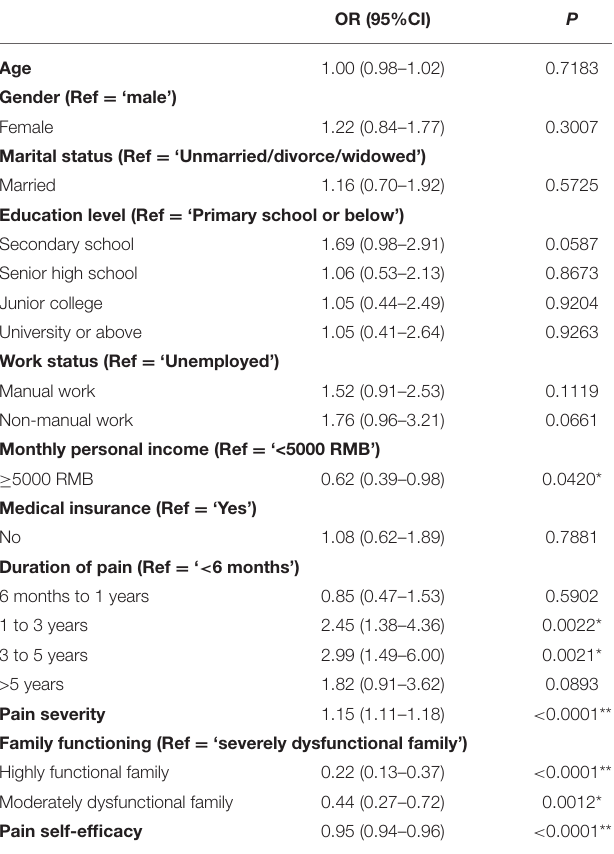
TABLE 2 | Binary logistic analysis of anxiety symptoms related factors in patients with chronic low back